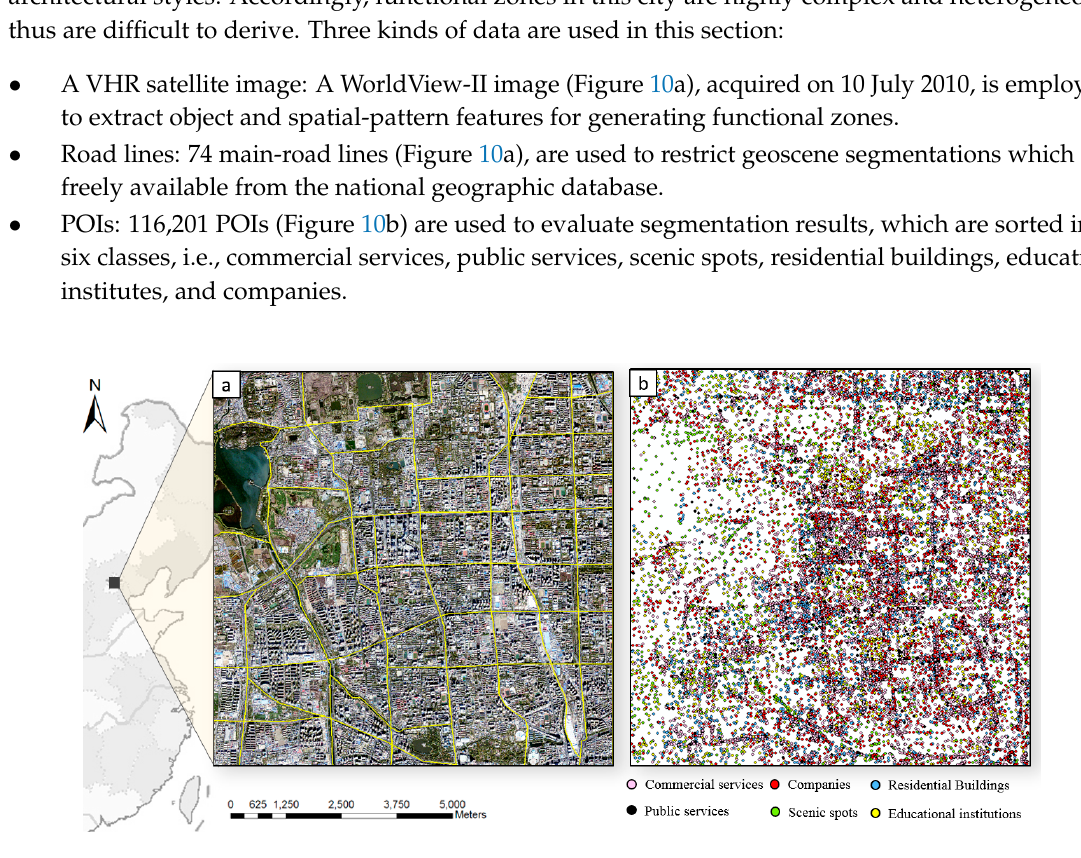
Figure 10. The study area in Beijing, China: ( a ) a WorldView-II image (in band combination 5/3/2, true color) and main road lines are used to generate functional zones; and ( b ) points-of-interest (POIs) are used to evaluate segmentation results.